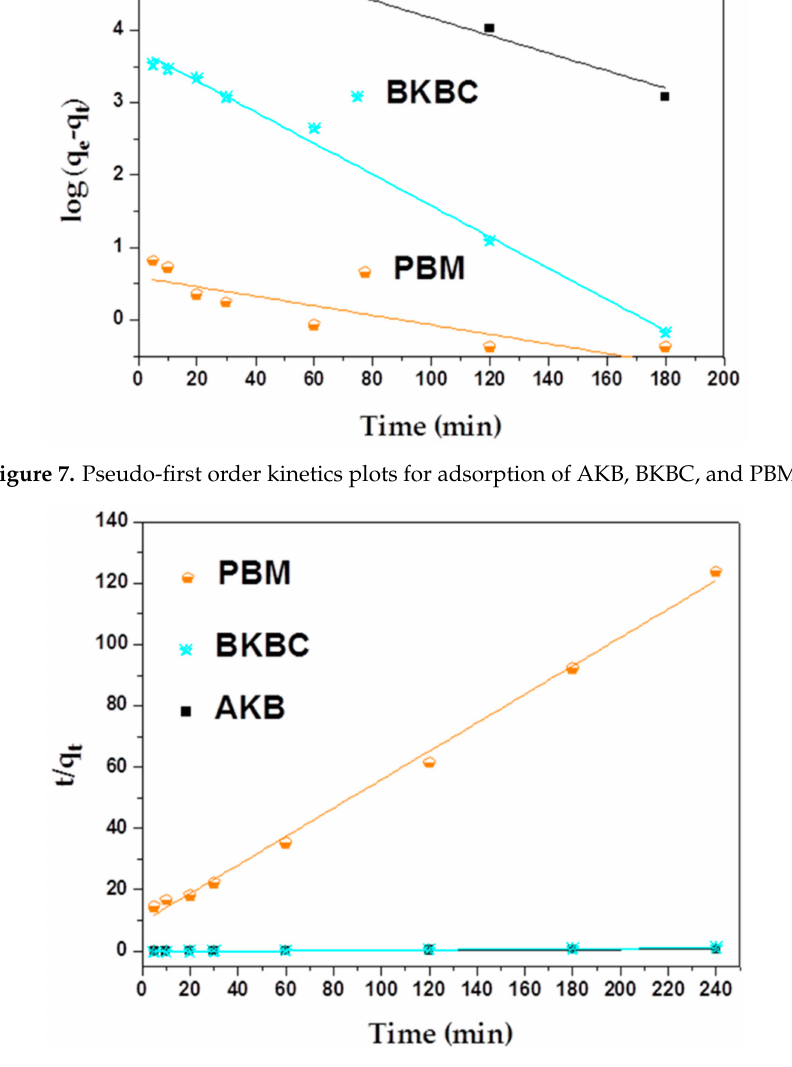
Figure 8. Pseudo-second order kinetics plots for adsorption of AKB, BKBC, and